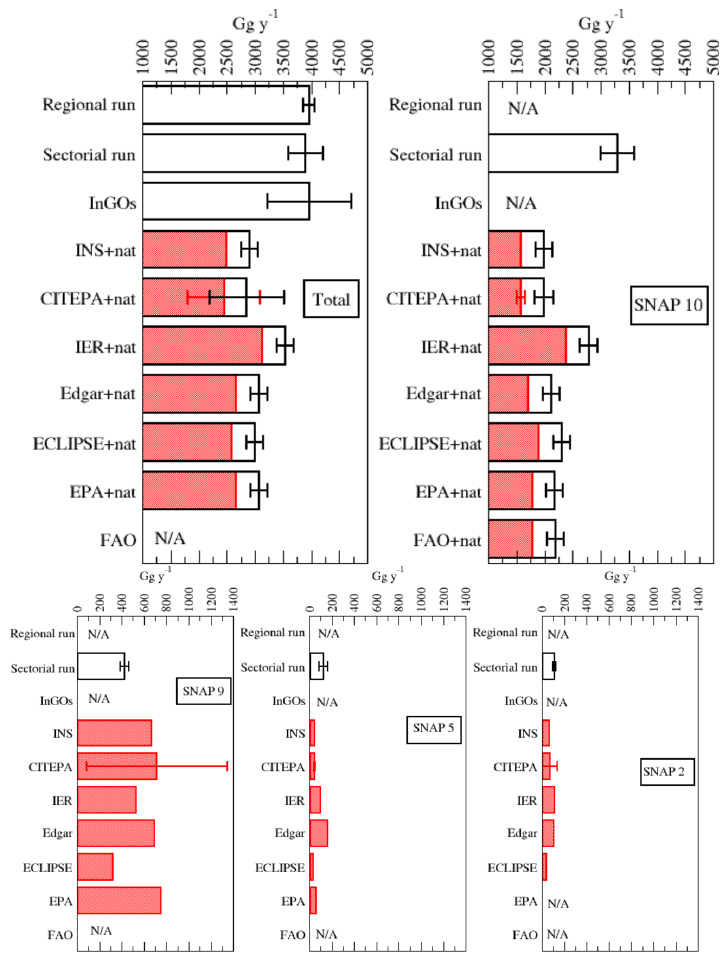
Figure 9. CH 4 yearly emissions (in GgCH 4 ) in France for this study and the other studies or inventories listed in Table 5. “Total”: the inventories including only anthropogenic emissions (in red) are summed-up with the natural emissions by wetlands and termites. For these totals (black bars), the error bars (in black) are obtained from the range of wetland emissions (Table 5) combined with the uncertainty in anthropogenic emissions (in red), when available i.e. only for CITEPA (Table 5). The CITEPA provides uncertainties only for the main emitting sectors so that the error bar on the total emissions is underestimated. “SNAP10”: the inventories including only anthropogenic emissions (in red) are summed-up with the natural emissions by wetlands and termites. Only the CITEPA provides an uncertainty (in red), which is combined with the range on wetland emissions to obtain the error bar on the whole sector (in black). Other sectors: only the CITEPA provides an uncertainty for these sectors. N/A = not-available or the definition of sectors or activities does not match those of